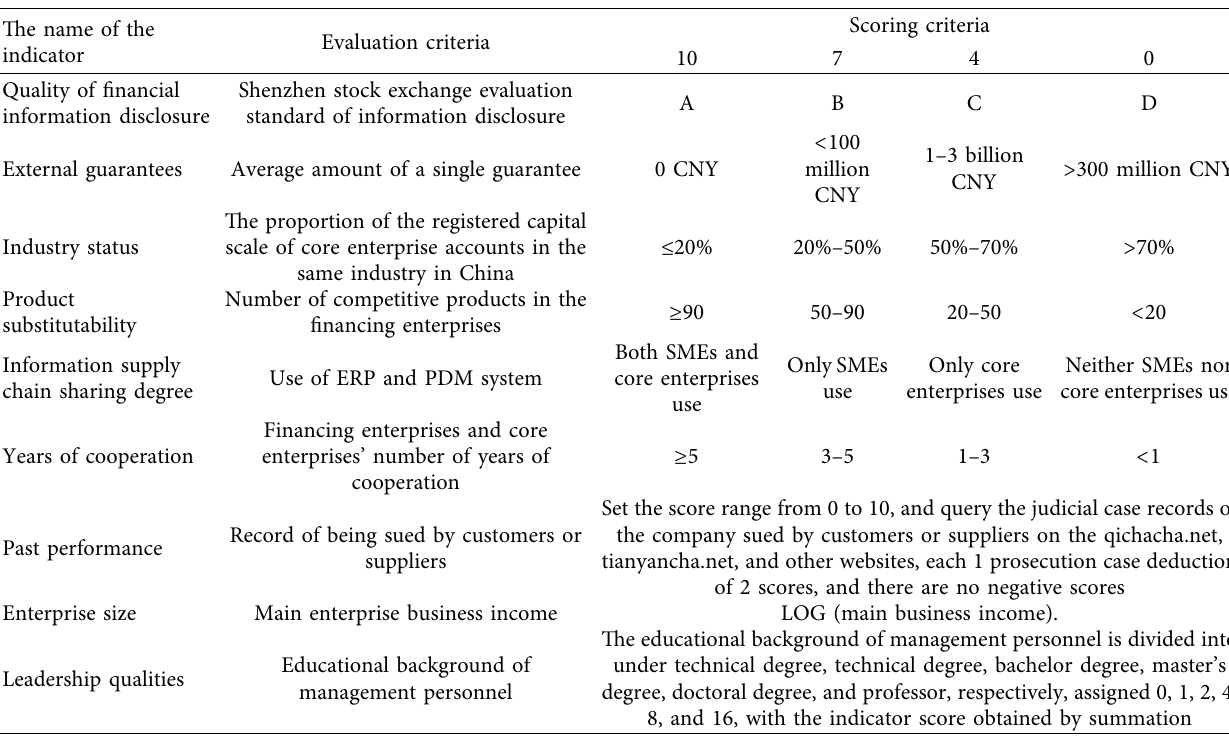
Table 2: Quantitative scoring standard.